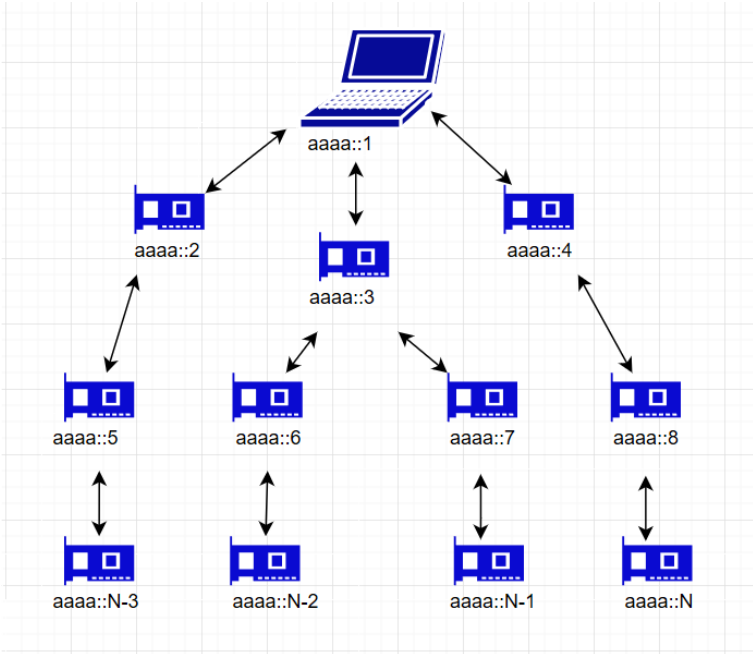
Figure 1. RPL DODAG with N Nodes from aaaa::1 to aaaa::N. Routing in RPL begins at the root node and routes are distributed to other protocols connected through the Destination Advertisement Object (DAO) message. RPL is more applicable in IoT where power supply is a regular constraint in low-energy and lossy networks.